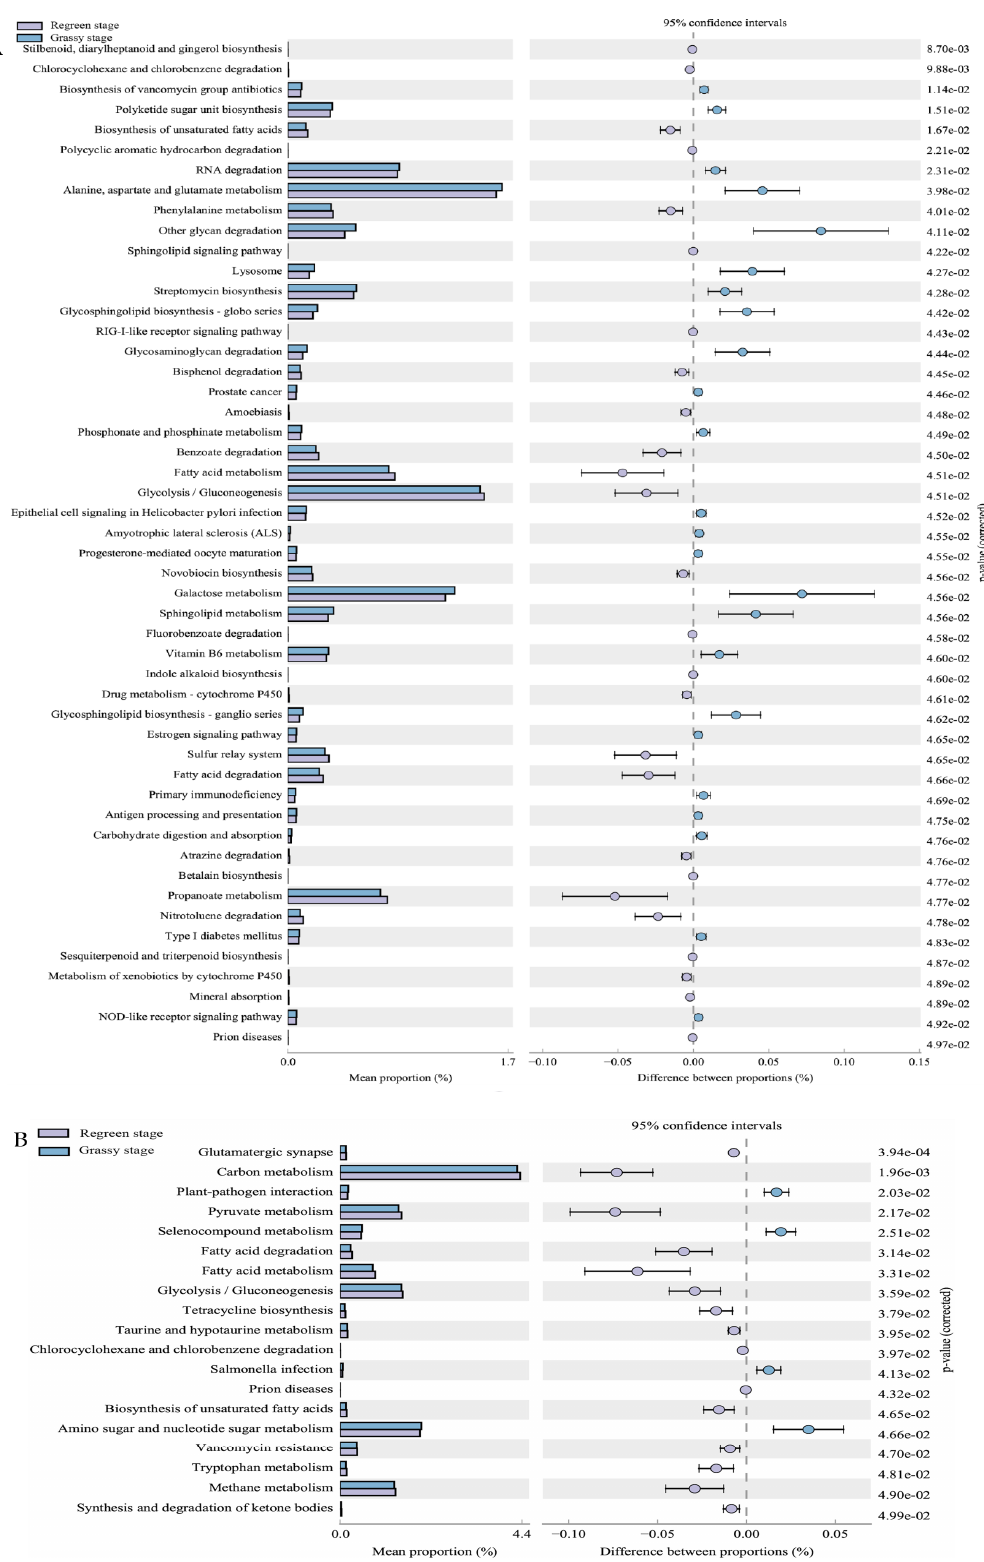
Figure 3. Functional profiles of microbial communities of hoggets (H) and rams (R) of grazing Alpine Merino sheep under different plant phenology. The extended error bars show significantly different KEGG pathways between the fractions. ( A ) relative abundance of metabolic pathways in hoggets (H); ( B ) relative abundances of pathways in rams